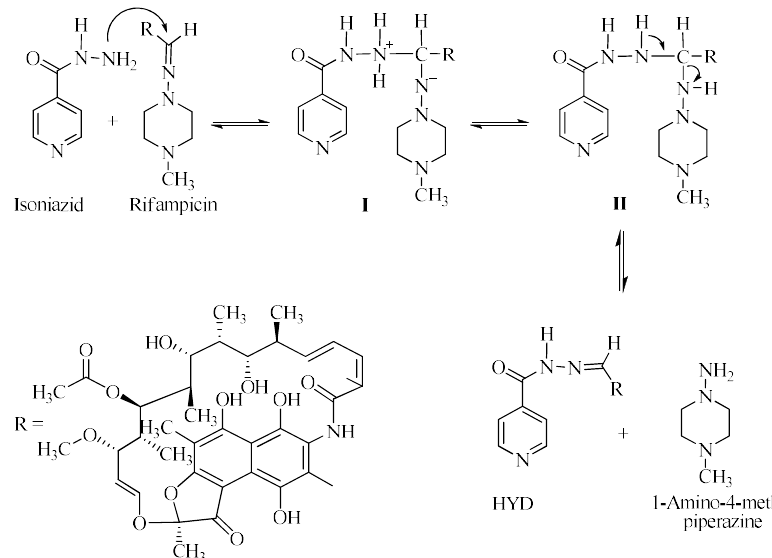
Figure 1. Mechanism of interaction between rifampicin (RIF) and isonicotinylhydrazide (INH), resulting in the formation of hydrazine (HYD).